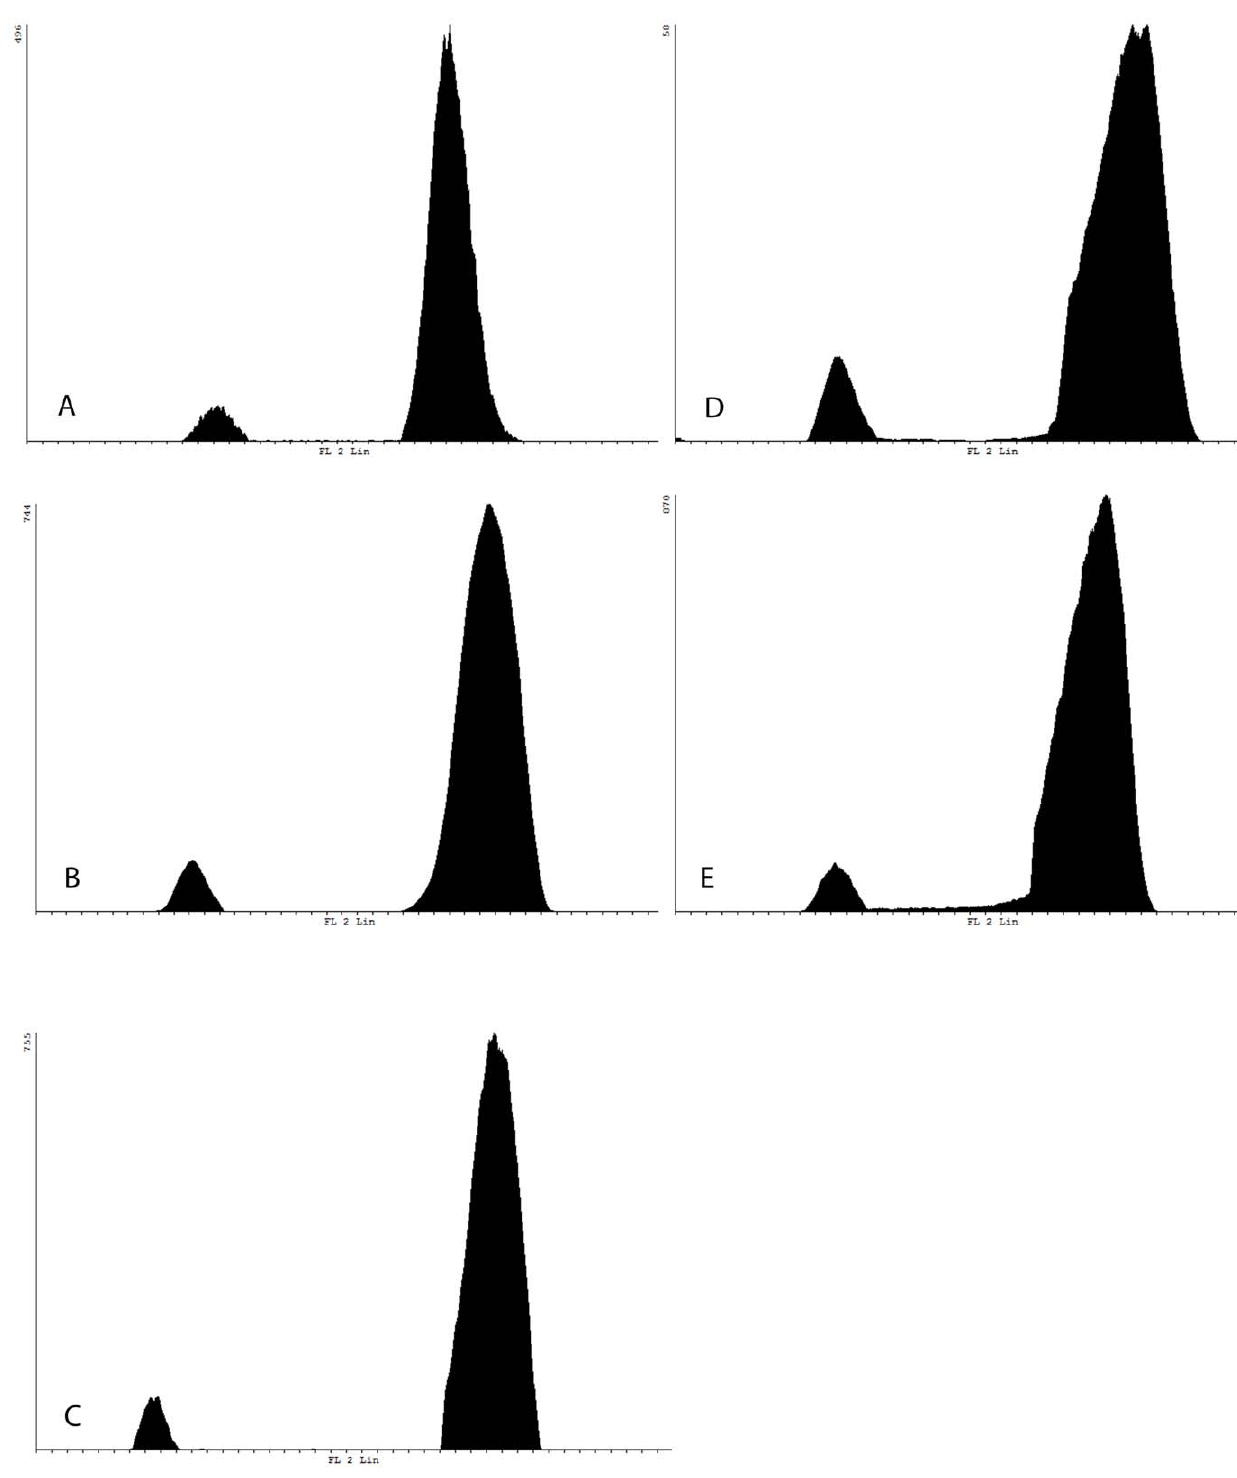
Figure 5. Fluorescence histograms for Artemiafranciscana and chicken DNA content estimation. Fluorescence histogram of four different A . franciscana male individuals with trout as the internal standard (A, B, C, D) and of chicken CEN with trout as the internal standard (E).